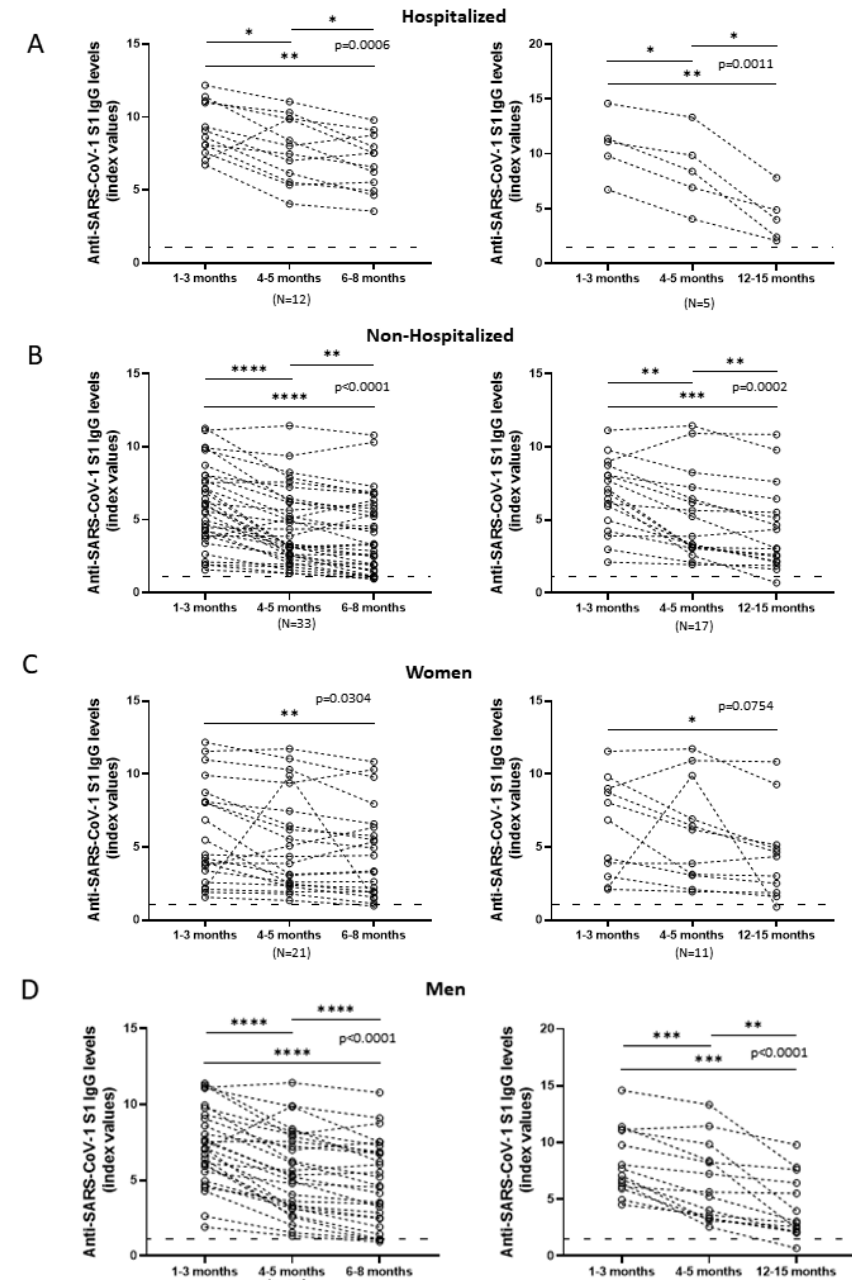
Figure 2. IgG responses targeting SARS-CoV-2 S1 over time for all different groups analyzed. Anti-S1 IgGs of all patients included in the study were measured at various time-points up to fifteen months. Patients whose last sample collection occurred six to eight months after infection (left side of the figure) were analyzed separately from those whose last sample collection occurred twelve to fifteen months after infection (right side of the panel). Circles on the graph represent a measurement at a certain time-point while dashed lines connect the three measurements of a single patient. Horizontal dashed lines represent the cut-off value of the assay used. p values indicated on the graph were calculated using repeated measures one-way ANOVA for all time-points, while post hoc analyses of two time-points at a time revealed statistical significance with * p < 0.05, ** p < 0.01, *** p < 0.001 and **** p < 0.0001. Antibody levels reduction of ( A ): All hospitalized patients. ( B ): All non-hospitalized patients. ( C ): All female patients. ( D ): All male